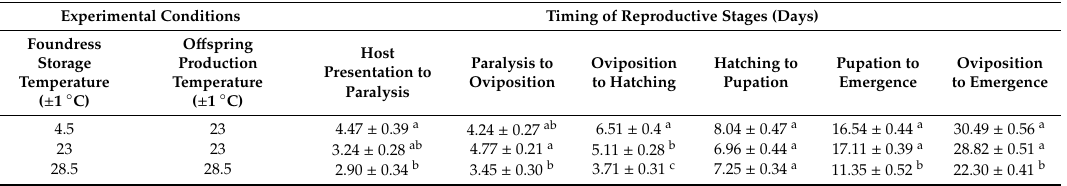
Table 5. Timing of reproduction by groups of Sclerodermus brevicornis foundresses following storage at di ff erent temperatures (means and standard errors are shown according to storage temperature, irrespective of the time stored at that temperature).